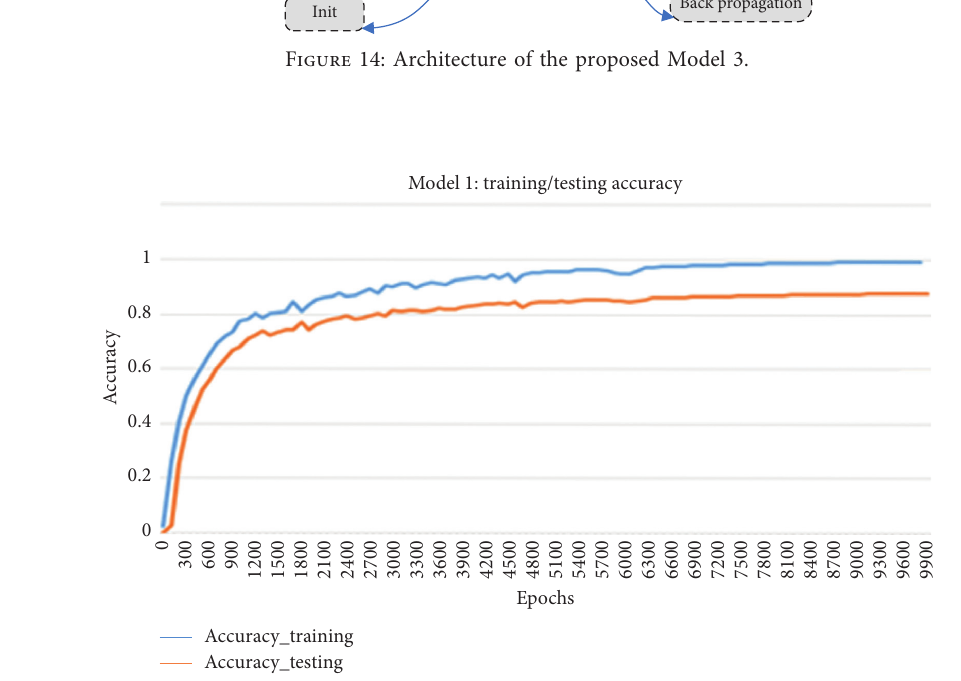
Figure 14: Architecture of the proposed Model 3.